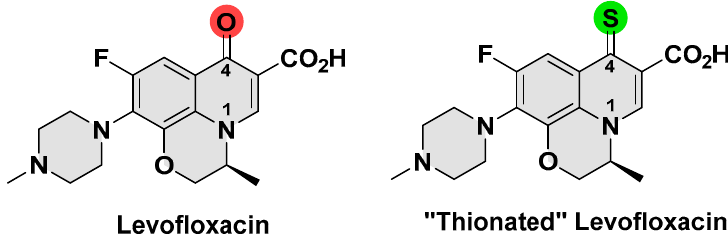
Figure 1. Chemical structure of levofloxacin and the thionated analogue.